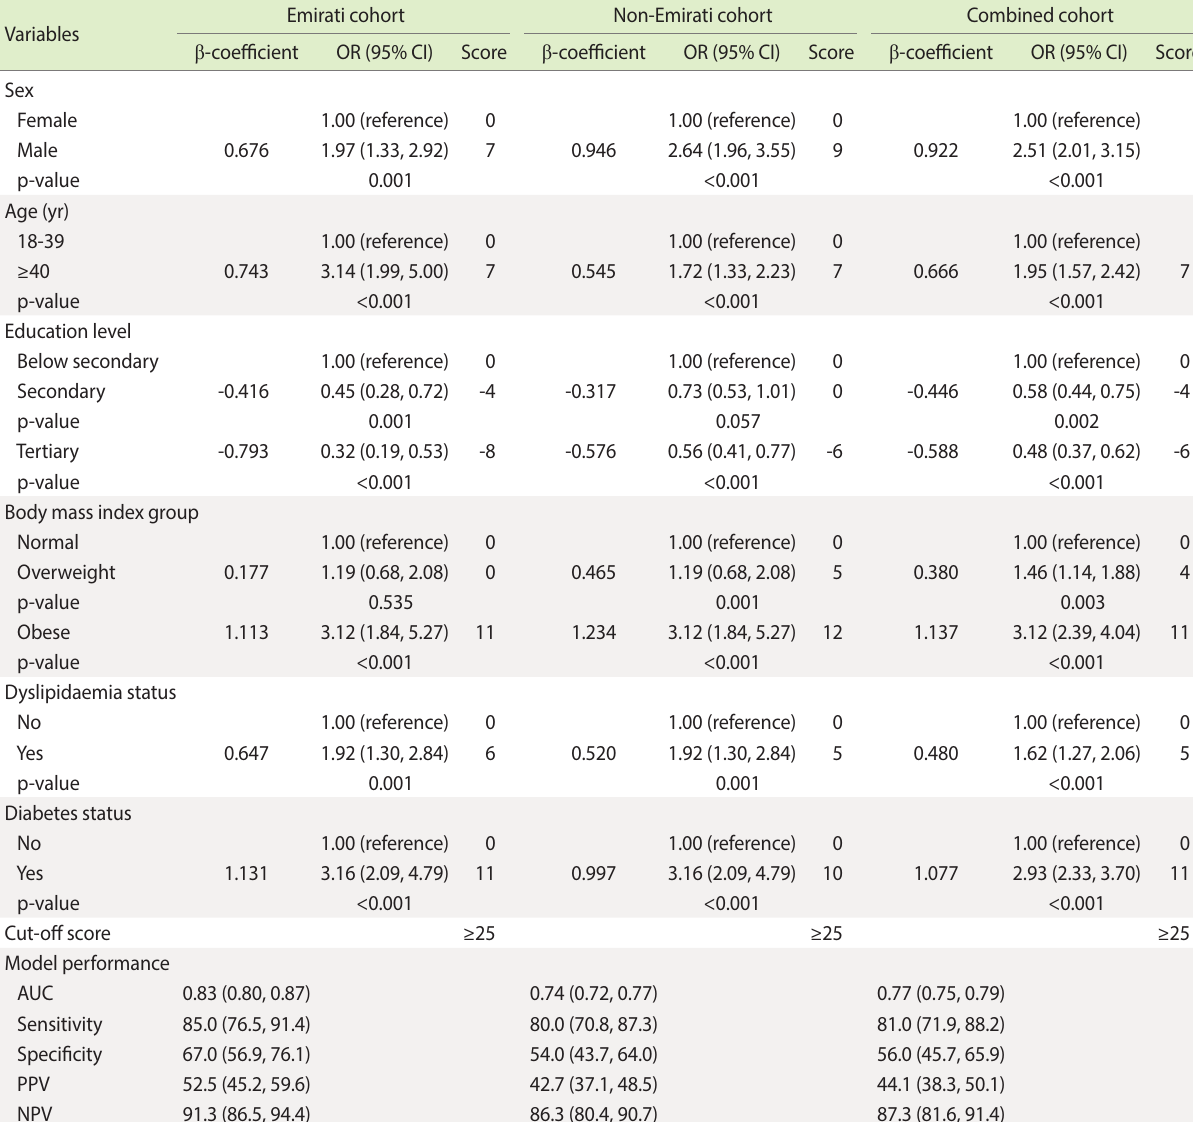
Table 2. Binary logistic regression models for the Emirati cohort and non-Emirati cohort and their performance